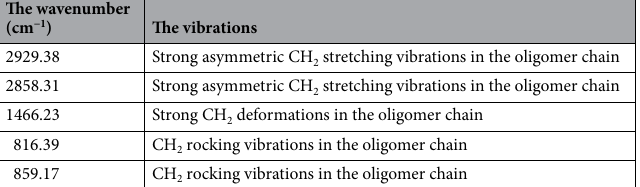
Table 2. IR results for the ethylene oligomer obtained using [Cr(dipic) 2 ][Cr(bipy)(dipic)(H 2 O)] ∙ 2 H 2 O as a catalyst.